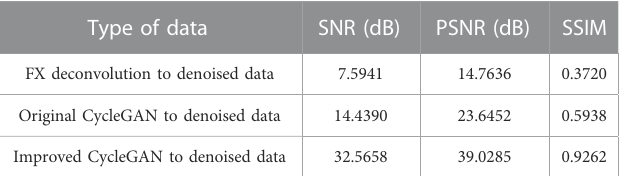
TABLE 2 Comparison of denoising effects on the real seismic